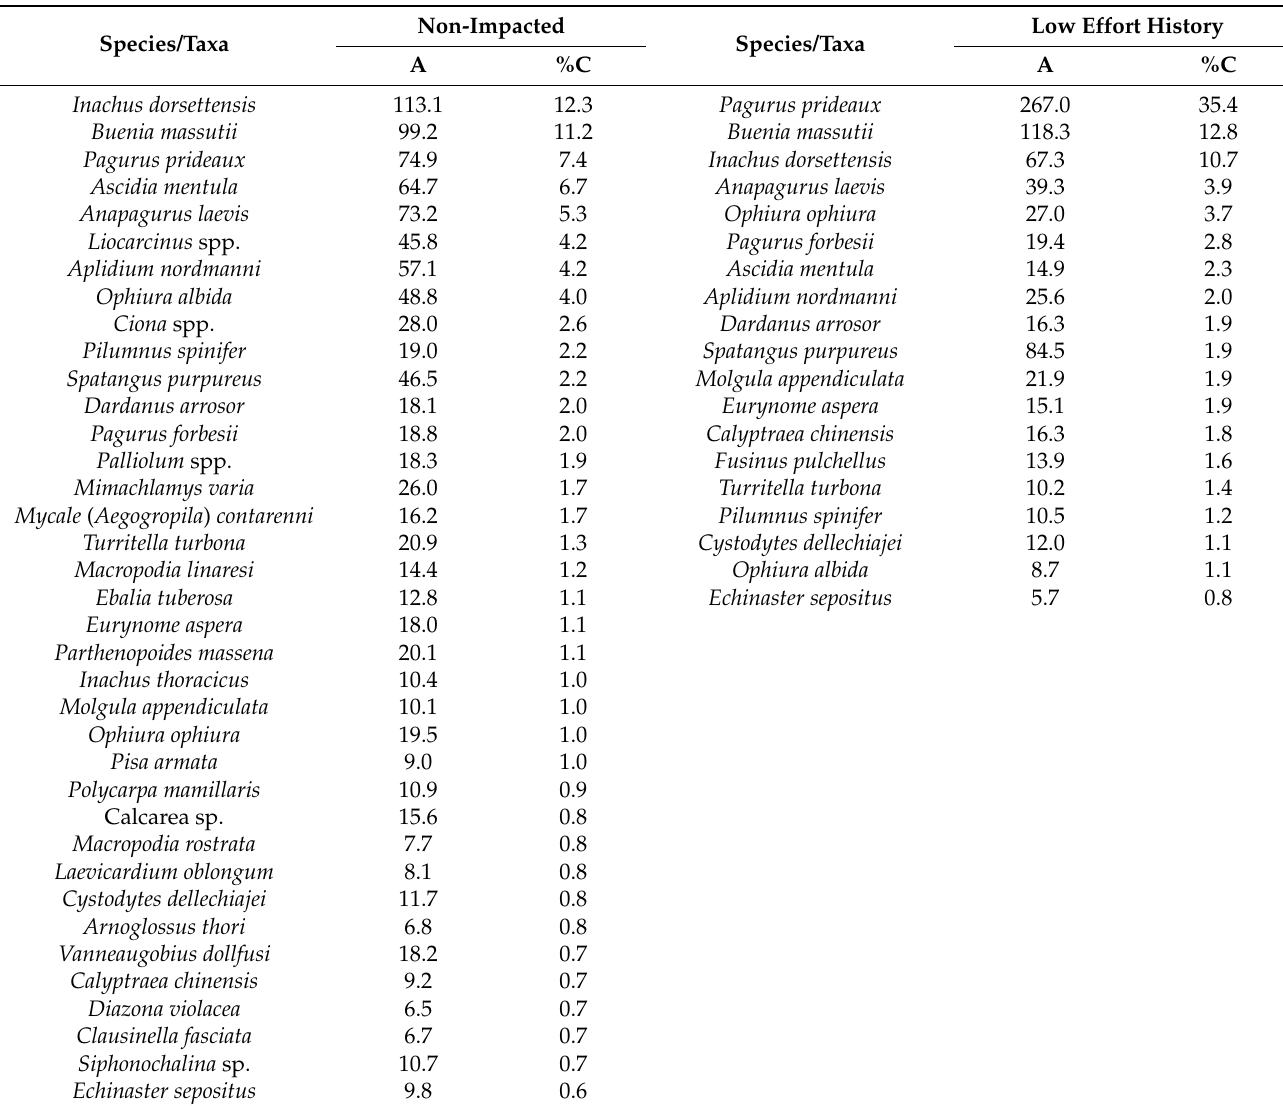
Table 2. Results of SIMPER analysis, estimated from standardized abundance data in beam trawl samples in Non-impacted and Low effort history areas, showing mean abundance (A; individuals/1000 m 2 ) and percentage contribution (%C) of each species contributing up to 90% of within-group